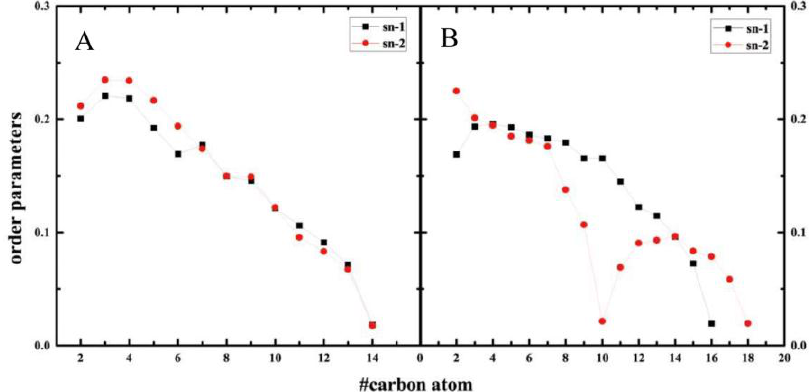
Figure 6. The total and decomposed electron density profiles of the lipid molecule. ( A ) The electron Figure 7. The order parameters for bilayer system averaged over the last 20 ns simulations. ( A ) The density profiles of the DMPG; ( B ) The electron density profiles of the POPS. order parameters for DMPG bilayer system; ( B ) The order parameters for POPS bilayer system.